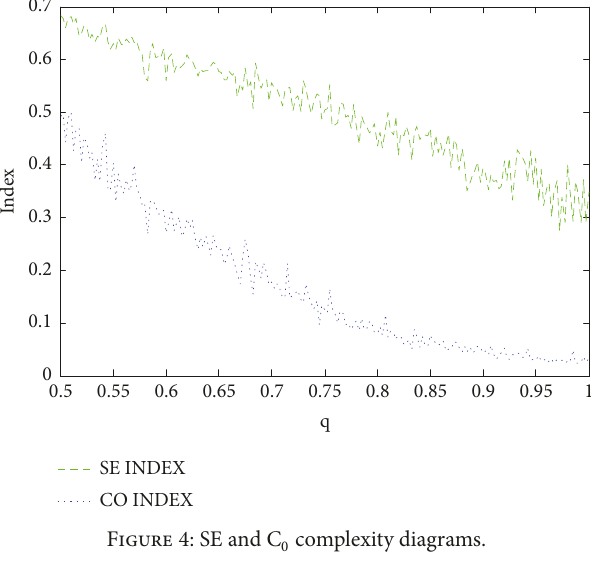
A and B are all stable, so hidden attractors appear here. Figure 4: SE and C 0 complexity diagrams.